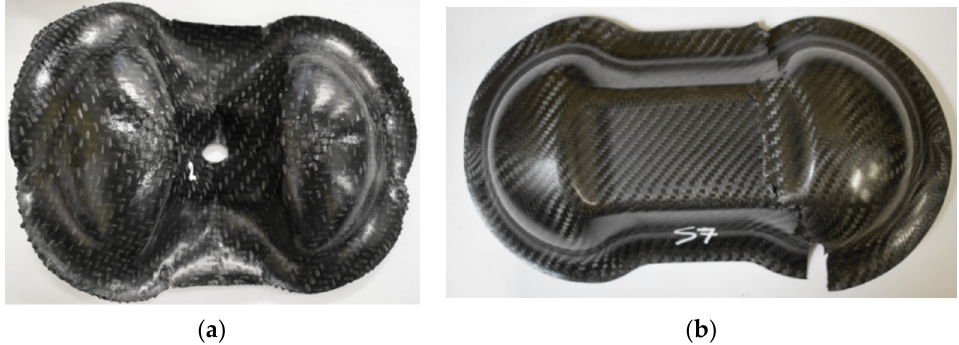
Figure 31. Double Dome specimens in GF/PP ( a ) and CF/EP-Solvay ( b ) after the bending test.